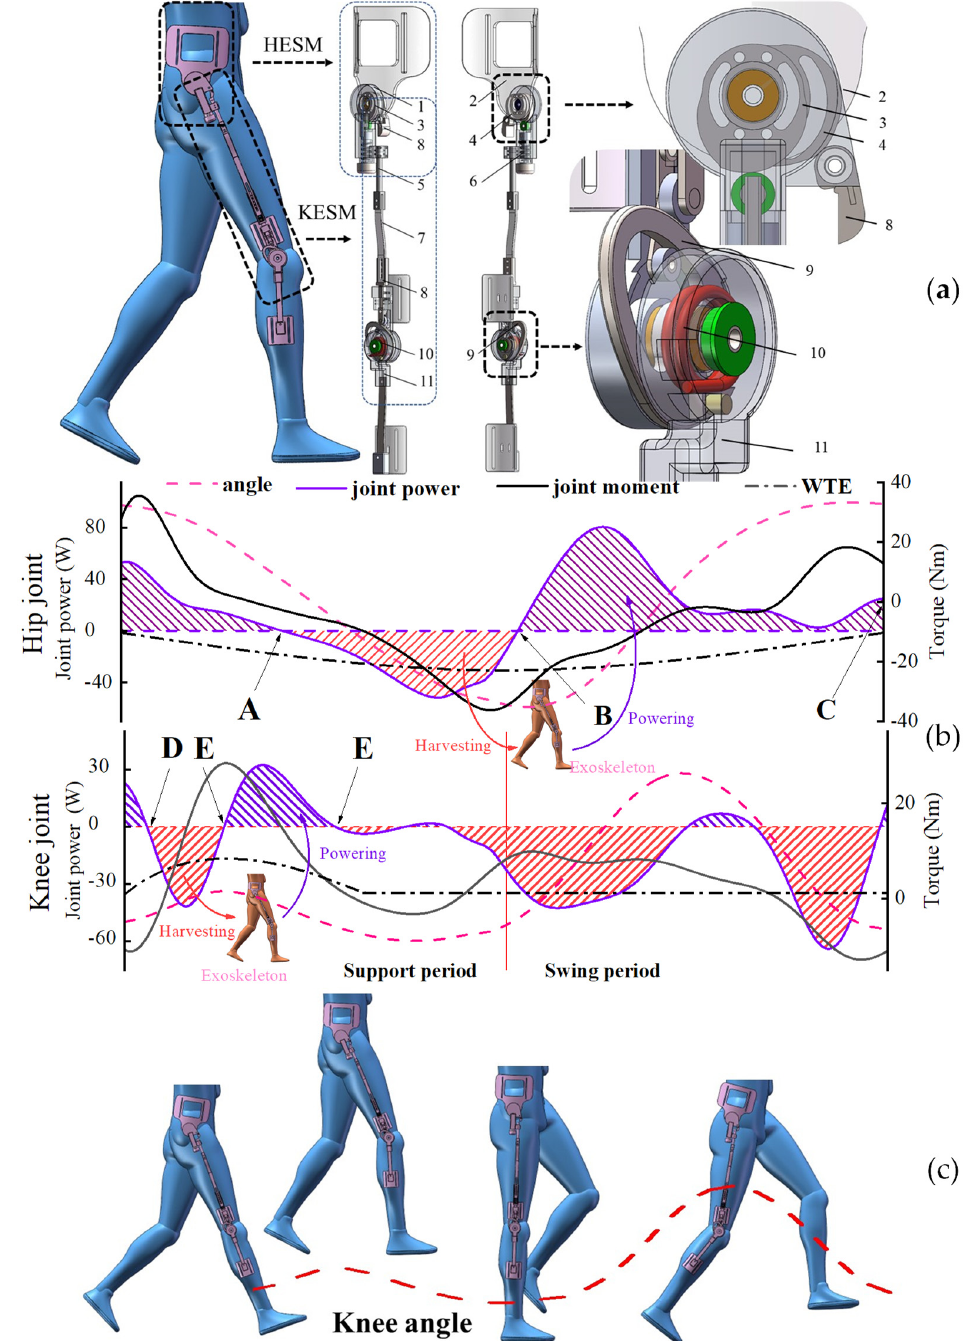
Figure 2. ( a ) Structure of the exoskeleton. 1—Hip shell cover, 2—Junction panel, 3—Main cam, 4— Minor cam, 5—Pushrod 1, 6—Pressure spring, 7—Pushrod 2, 8—Pushrod 3, 9—Cam, 10—Torsional spring, 11—Shell cover. ( b ) Movement characteristics of the lower limb joints. ( c ) Movement char ‐ acteristics of the exoskeleton.